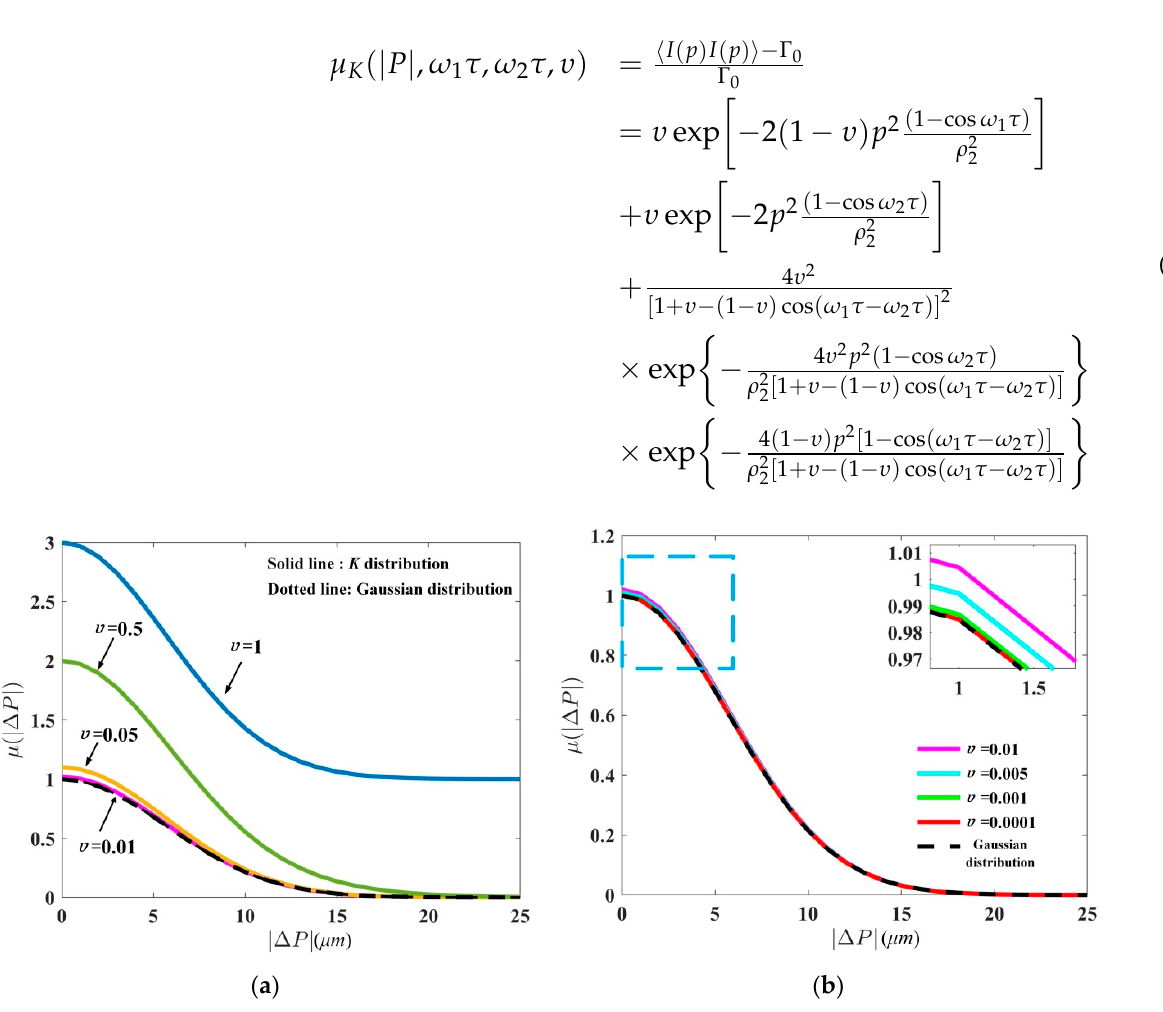
Figure 2. Relationship of spatial correlation function µ ( | ∆ p | ) with the spatial difference | ∆ p | for various values of υ . ( a ) 0.01 < υ < 1; ( b ) υ ≤